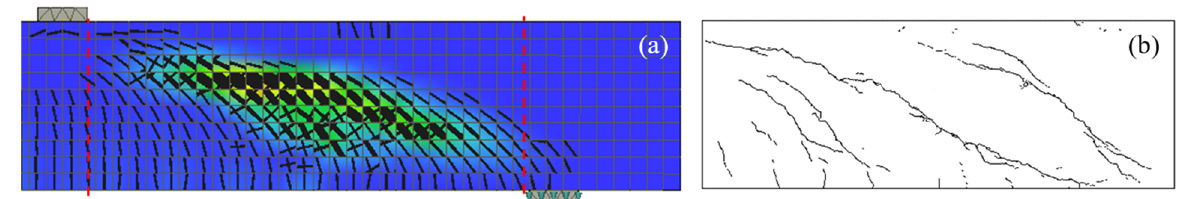
Figure 12. Crack patterns of the ( a ) FEM and the ( b ) experiment at peak load.